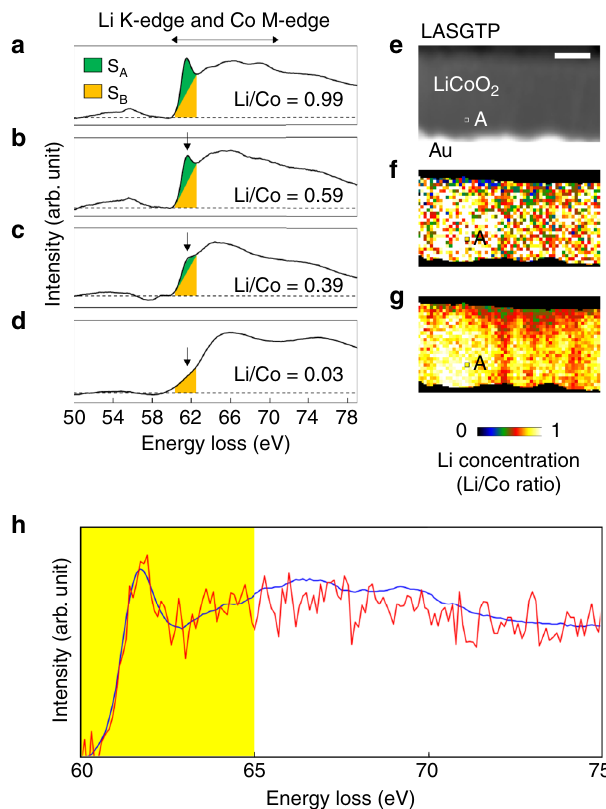
Fig. 2 Quanti fi cation and denoising of the EEL spectra by MLLS fi tting. a – d Reference EEL spectra acquired from delithiated reference Li x CoO 2 particles ( x = 0.99, 0.59, 0.39, and 0.03) used for the S A / S B method and MLLS fi tting. Reprinted with permission from ref. 17 . Copyright (2018) American Chemical Society. e ADF-STEM image where the SIs were acquired. f Li concentration map obtained from the original low-dose SI with low SNR. g Li concentration map obtained from the MLLS- fi tted SI. The pillar domains of LiCoO 2 can be observed. h EEL spectra at the pixel indicated by point A in e – g . The red and blue spectra were extracted from the original and MLLS- fi tted SI, respectively. The scale bar in e is 100